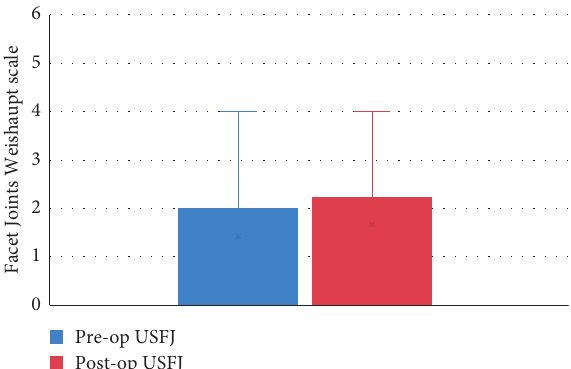
Figure 3: Preoperative and 1-year postoperative Weishaupt scale scores of the upper segment facet joints. USFJ, upper segment facet joints.